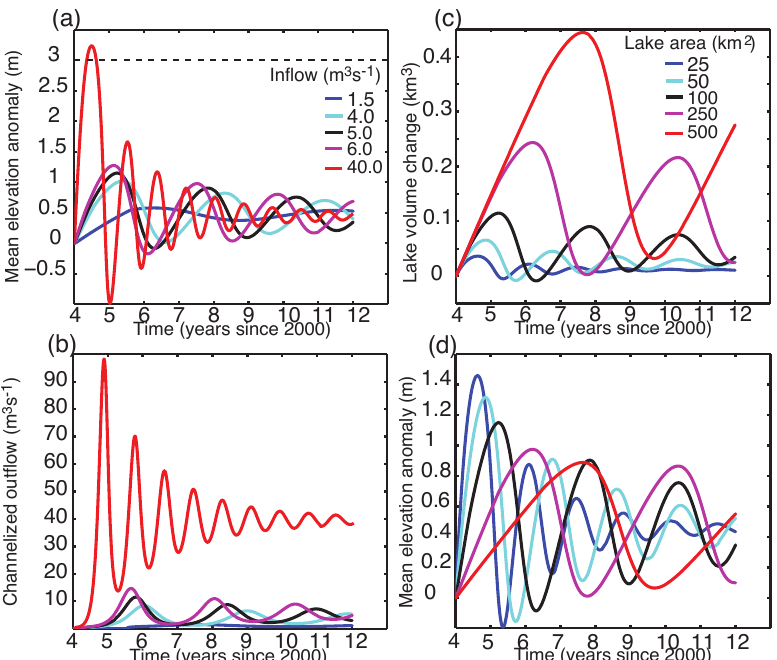
Figure 9. Sensitivity of canal model to inflow and lake area. Variation in (a) surface elevation anomaly ( z sL ) and (b) channelized outflow ( Q CC ) due to changes in inflow ( Q in ). Variation in (c) lake volume ( V L ) and (d) mean elevation anomaly ( z sL ) due to changes in lake area ( A L ). The black lines denote the “control” run using our preferred parameter values (Table